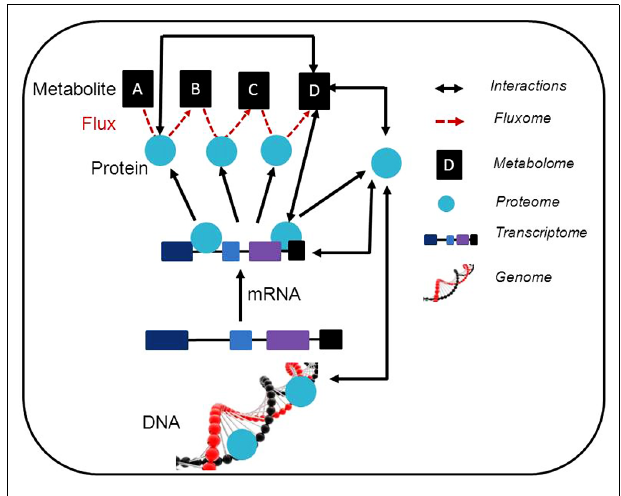
FIGURE 1 | Schematic representation of a synergetic integration of multiple omics approaches. Within individual experiments, a range of data is generated.This data can be associated with different levels of omics and the possible interactions are illustrated.The usage of modeling approaches linking the interactions between the results obtained using different post-genomic techniques is expected. Additionally, the data obtained can be deposited in specific database contributing to the construction of general prediction databases (e.g. coexpression database). This also allows the generation of further testable hypothesis and to adjust such hypothesis for individual